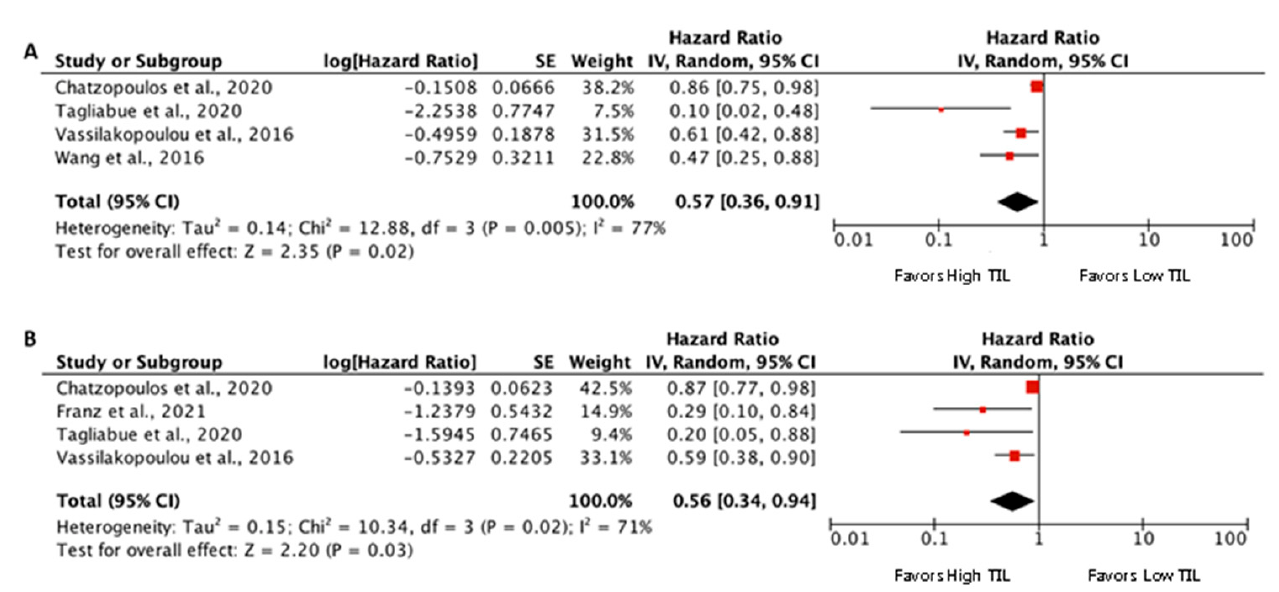
Figure 2. Forest plots of prognostic value of stromal TIL on hematoxylin-eosin-stained sections on overall survival ( A ) and disease-free survival ( B ).